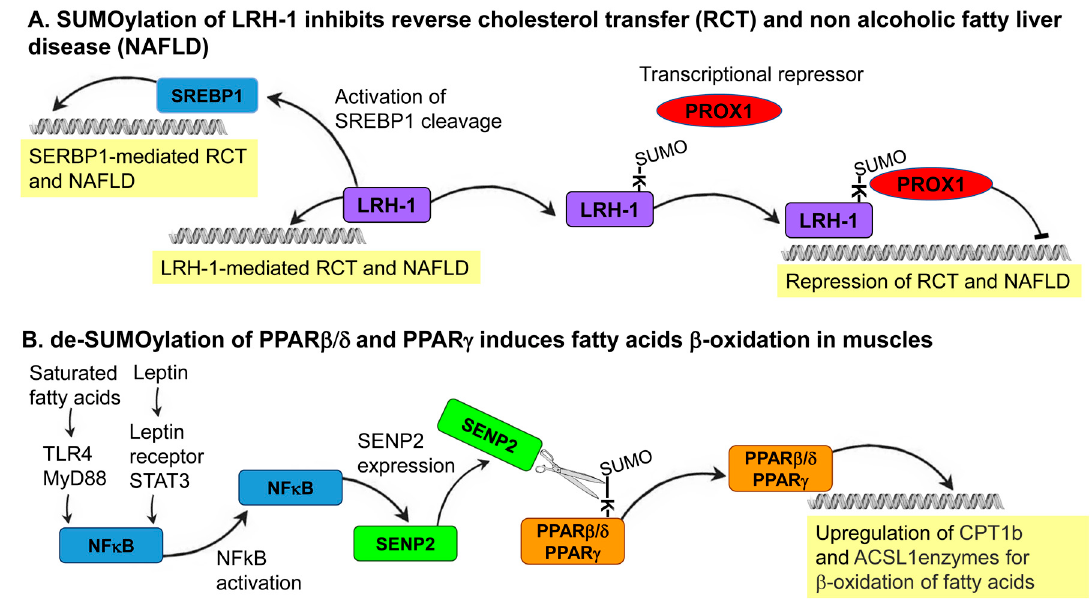
Figure 4. Two cases-in-point of the regulation of lipid homeostasis by the SUMOylation of nuclear receptors (NRs). ( A ) In a mouse model system, Liver Receptor Homolog-1 (LRH-1) coordinates programs of reverse cholesterol transport (RCT) and cholesterol metabolism. SUMOyaltion of LRH-1 results in the recruitment of the transcriptional-repressor PROspero-related homeoboX 1 (PROX1) to the LRH-SUMO protein. The LRH/PROX1 complex inhibits the expression of genes that function in RCT and in cholesterol and bile acid excretion [29]. UnSUMOylated LRH-1 also promotes SREBP1 activation and the execution of lipogenesis programs in the liver, which leads to the development of nonalcoholic fatty liver disease [66]. ( B ) In the mouse skeletal muscle-derived cell line, C2C12, the supplementation of saturated fatty acids activates the toll-like receptor 4 (TLR4) and its adaptor MyD88 [31]. This activation results in NFkB-mediated upregulation of the SUMO protease SENP2, which sheds SUMO from PPAR β / δ and PPAR γ . This deconjugation leads to the transcriptional upregulation of fatty-acid oxidation-associated enzymes, such as carnitine palmitoyl transferase-1 (CPT1b) and long-chain acyl-CoA synthetase 1 (ACSL1). SENP2 upregulation was also demonstrated following the treatment of C2C12 cells with the hormone leptin that activates the STAT3 transcription factor [71]. In SENP2 knockout mice, leptin treatment does not upregulate CPT1b and ACSL1 levels as well as fatty acid β -oxidation, demonstrating the in vivo significance of the link between the SUMOylation of PPAR proteins and lipid metabolism